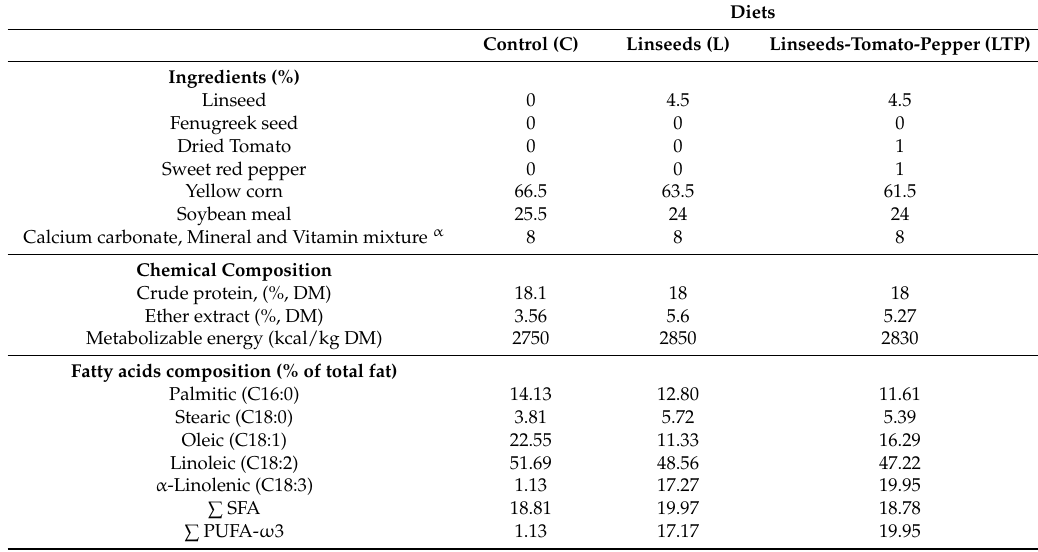
Table 1. Ingredients, and chemical and fatty acids composition of the experimental diets *. Diets Control (C) Linseeds (L) Linseeds-Tomato-Pepper (LTP) Ingredients (%) Linseed 0 4.5 4.5 Fenugreek